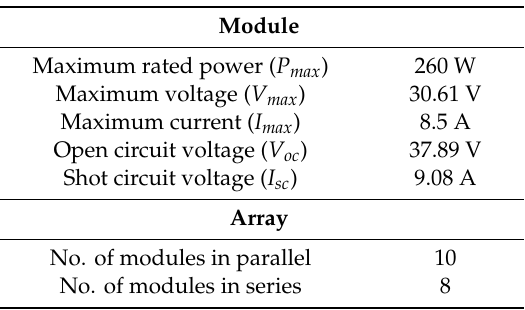
Table 1. PV (photovoltaic) model parameters.